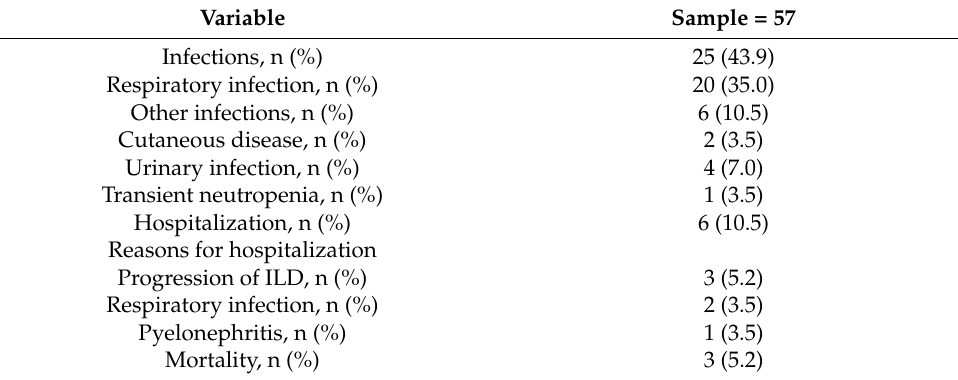
Table 3. Adverse events in 57 patients with RA-ILD treated with